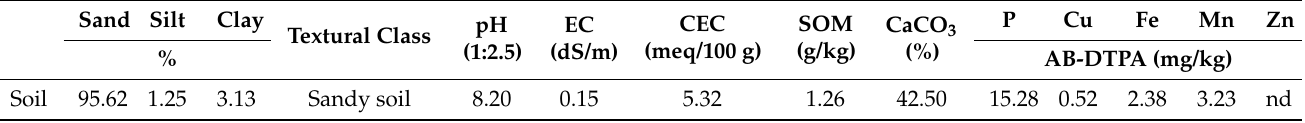
Table 1. Properties of